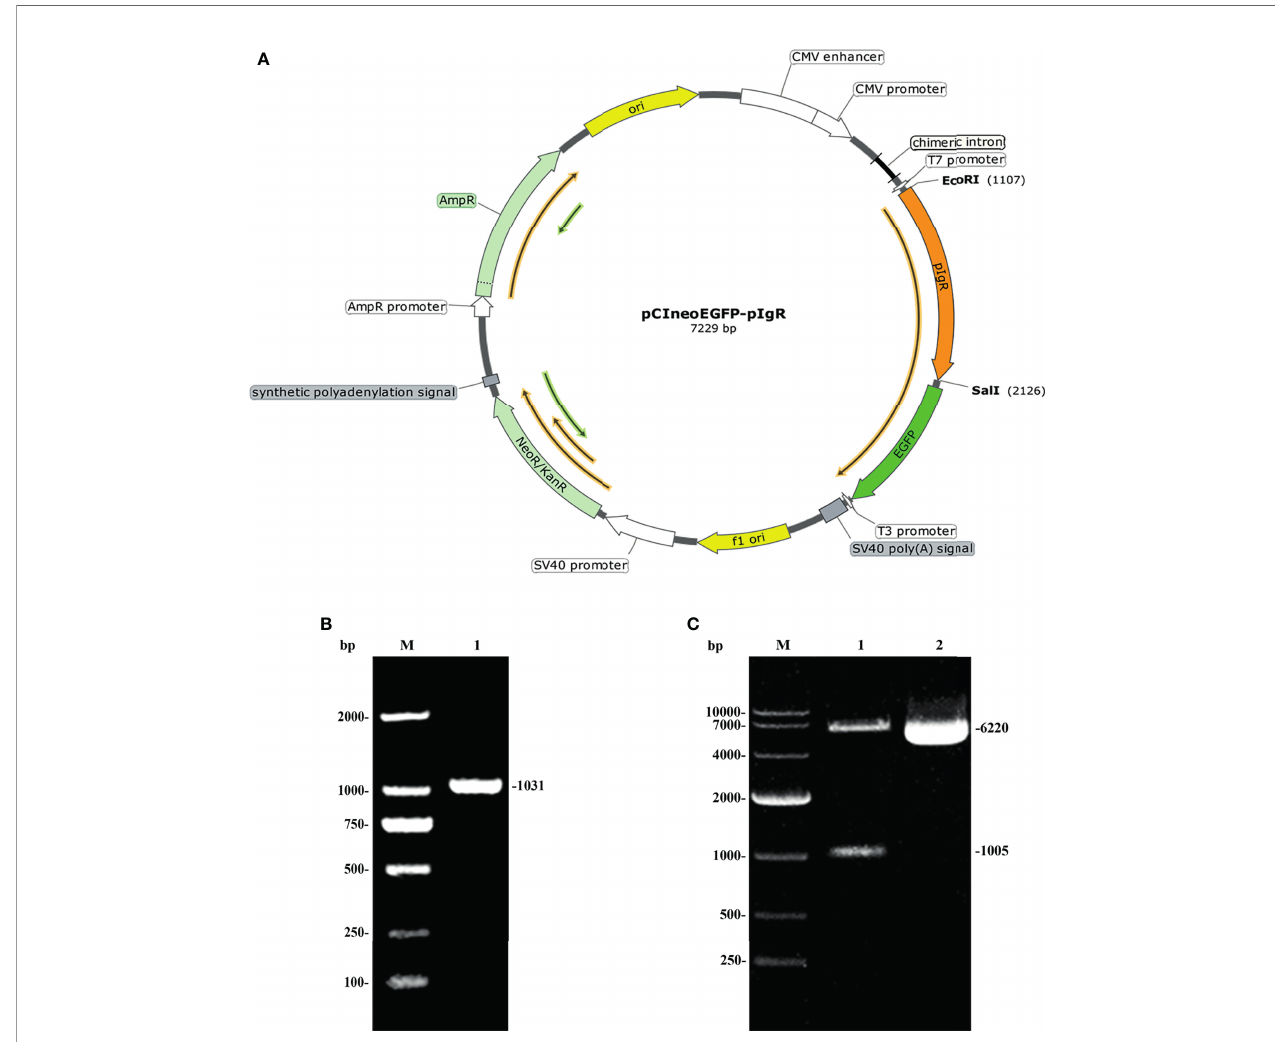
FIGURE 4 | Construction of an expression vector encoding the pIgR of fl ounders. (A) Map of pCIneoEGFP-fpIgR eukaryotic plasmid. (B) Ampli fi ed fpIgR PCR products with EcoRI and SalI endonuclease sites. M: DNA marker DL 2000; lane 1: ampli fi ed PCR product. (C) Agarose electrophoresis of pCIneoEGFP-fpIgR eukaryotic plasmid and its double-digestion